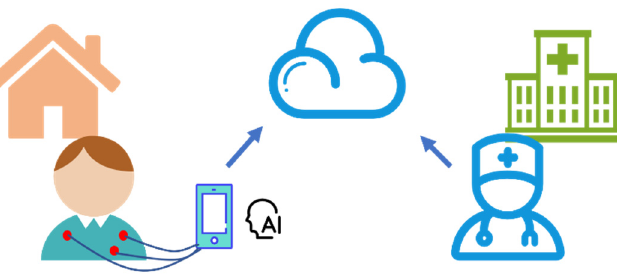
Figure 12. Application scenario of IoT for ECG diagnostics. Patients can diagnose locally through offline algorithms and share diagnostic information with hospitals through cloud services.